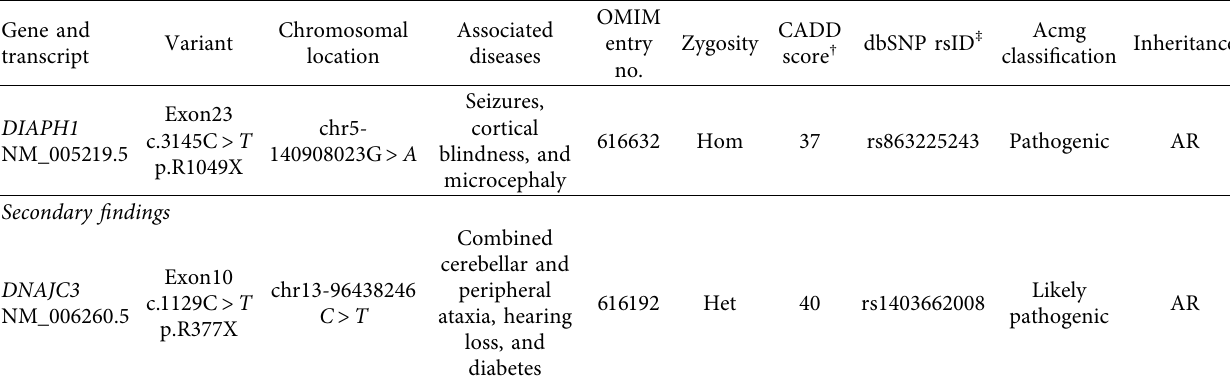
Table 2: Details of the results of whole genome